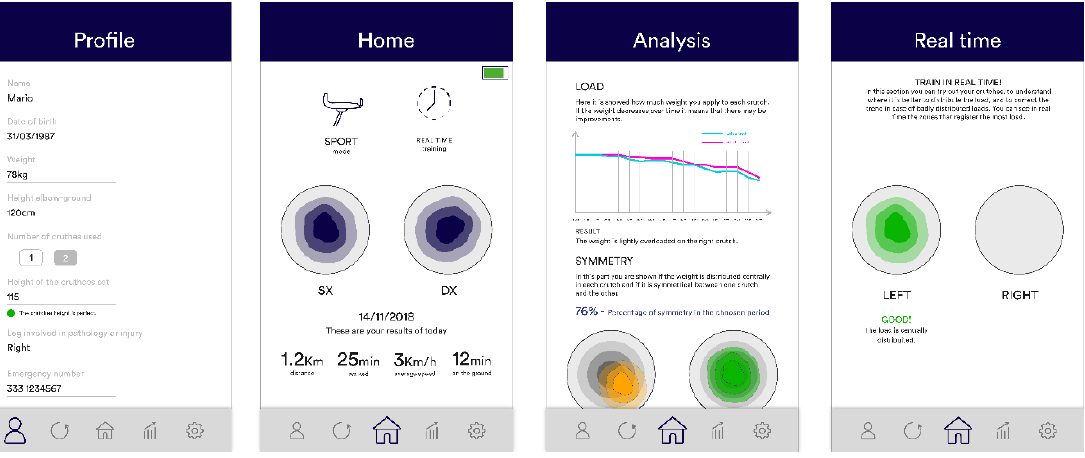
Figure 12. Some App mock-ups.